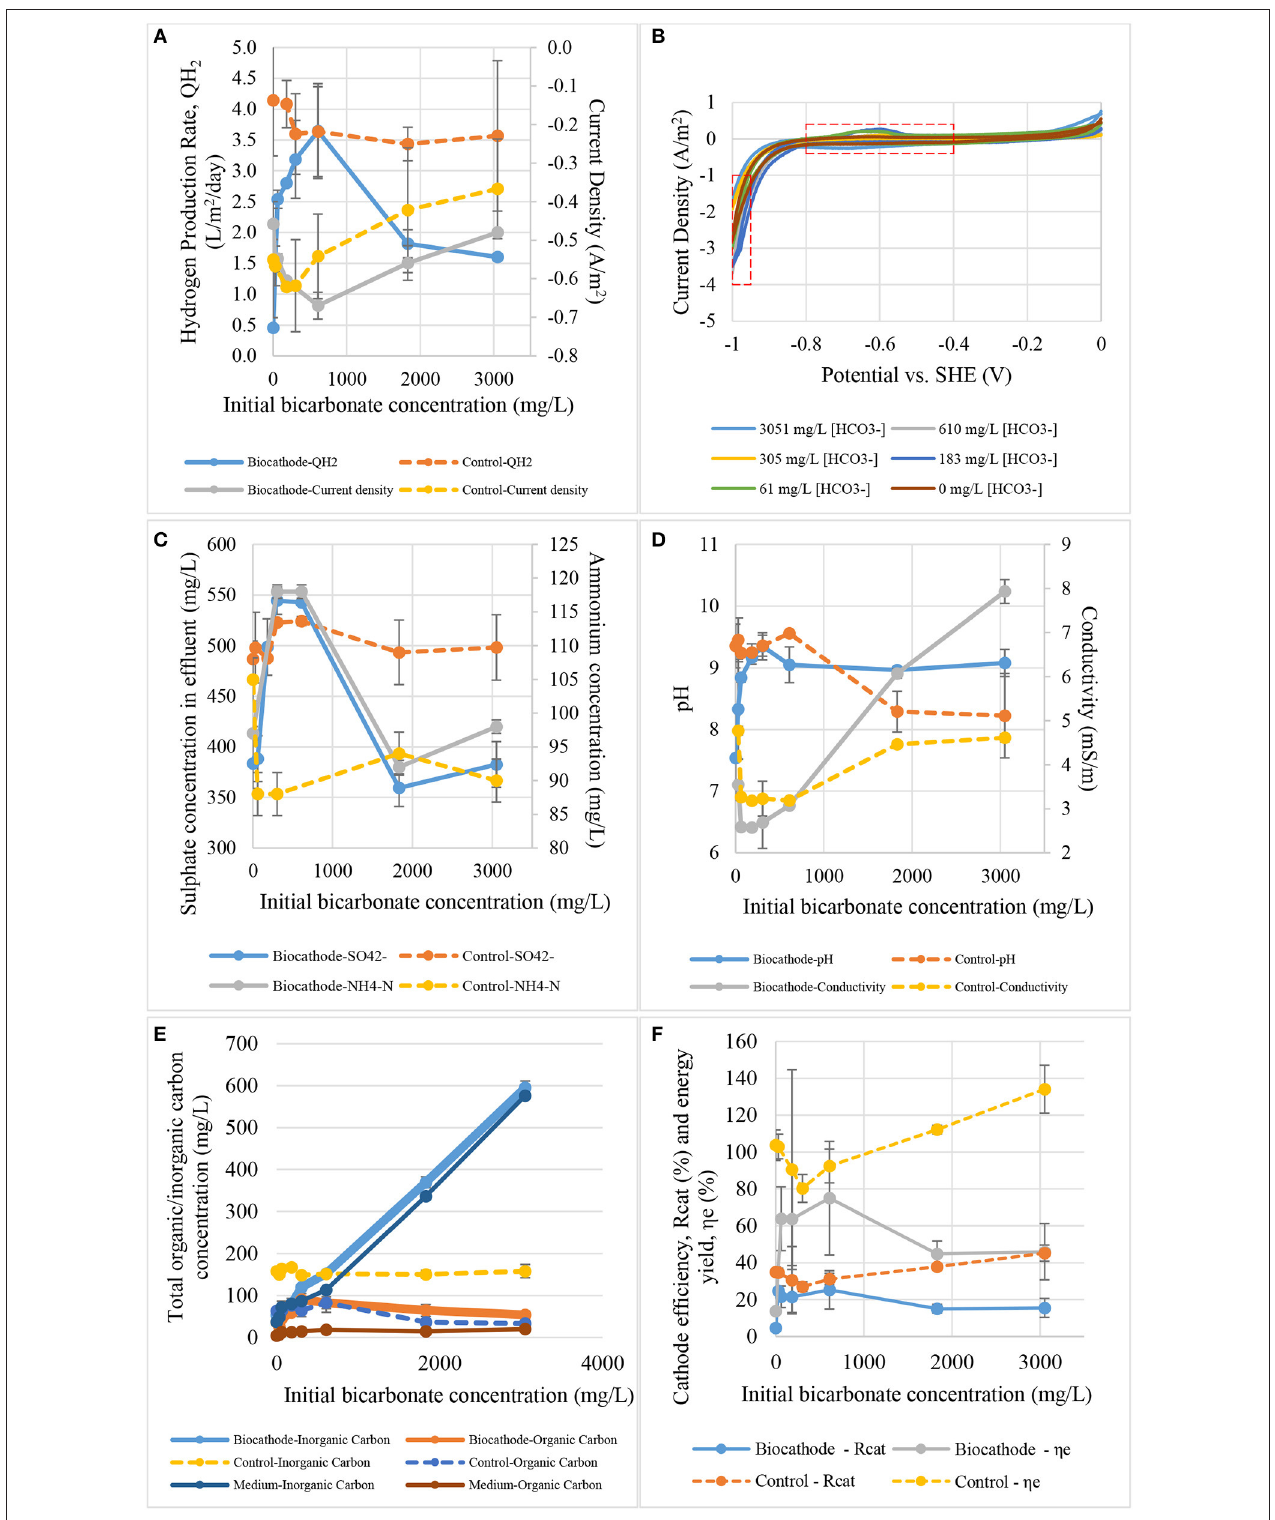
FIGURE 7 | The effect of initial bicarbonate concentration on: (A) hydrogen production rate and current density, (B) catalytic activity, (C) sulfate and ammonium contents, (D) pH and conductivity, (E) total carbon content, and (F) cathode efficiency and energy yield.